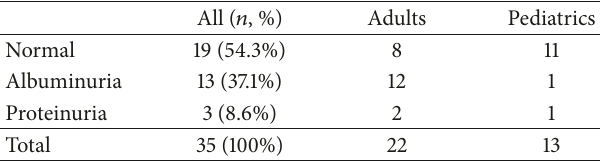
Table 3: Loss of protein in urine.